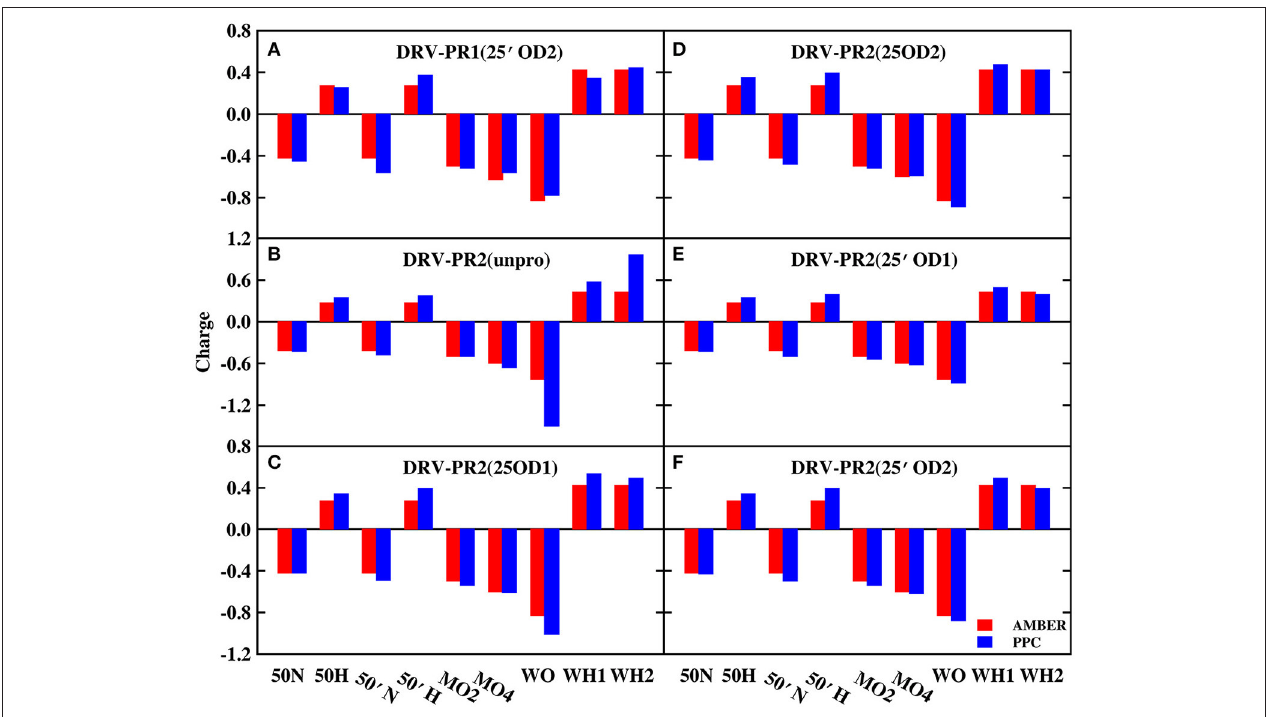
FIGURE 2 | The charge of bridging water molecules and surrounding atoms that form hydrogen bonds in DRV complex. MO2, MO4, and MO5 represent O2, O4, and O5 atoms of ligand molecule, respectively. WO, WH1, and WH2 represent bridging water molecule. (A) DRV-PR1(25 ′ OD2) system. (B) DRV-PR2(unpro)